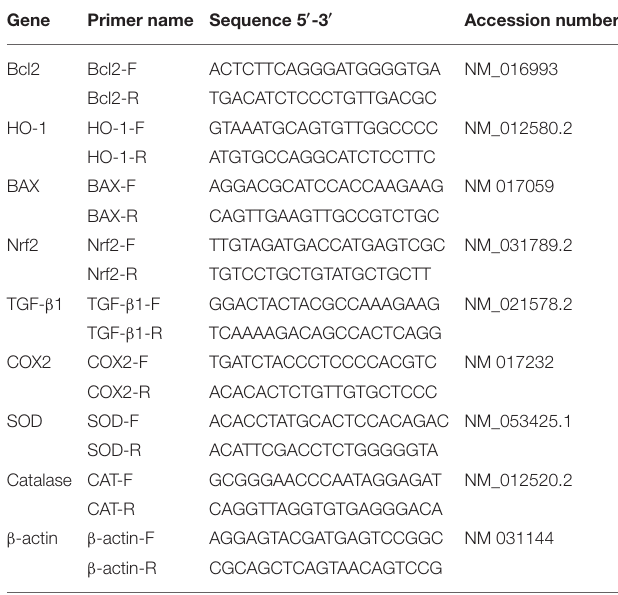
TABLE 1 | Summary of primer information used for quantitative real-time PCR in rat